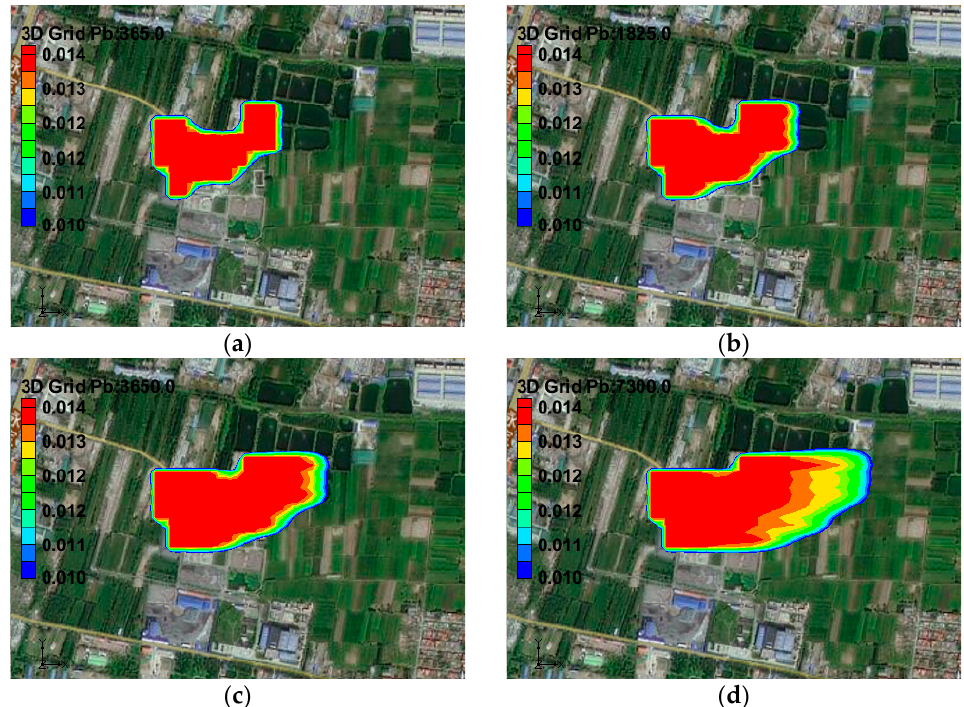
Figure 9. Pb concentration distribution map. ( a ) After 1 year; ( b ) After 5 years; ( c ) After 10 years; ( d ) After 20 years.